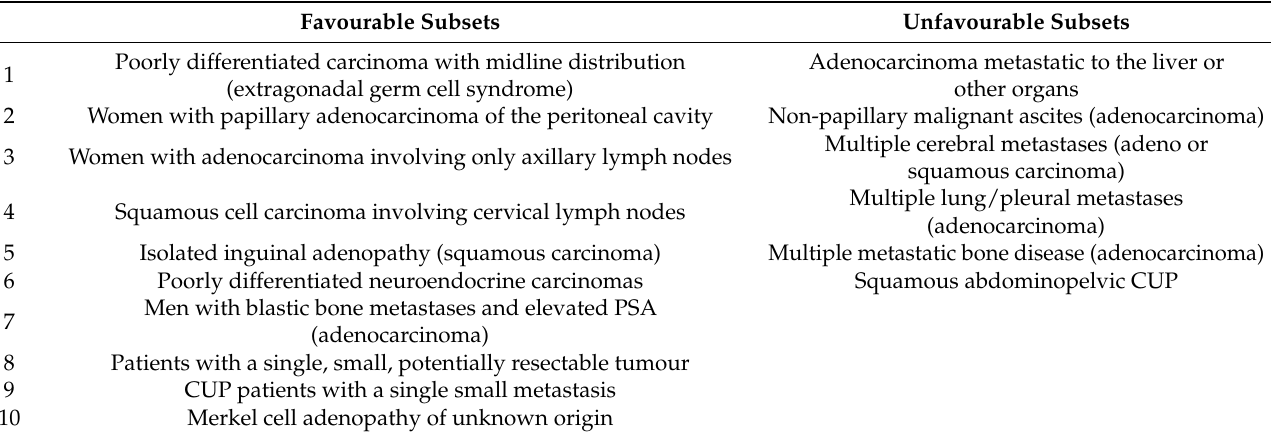
Table 1. List of the favourable and unfavourable subtypes. Favourable